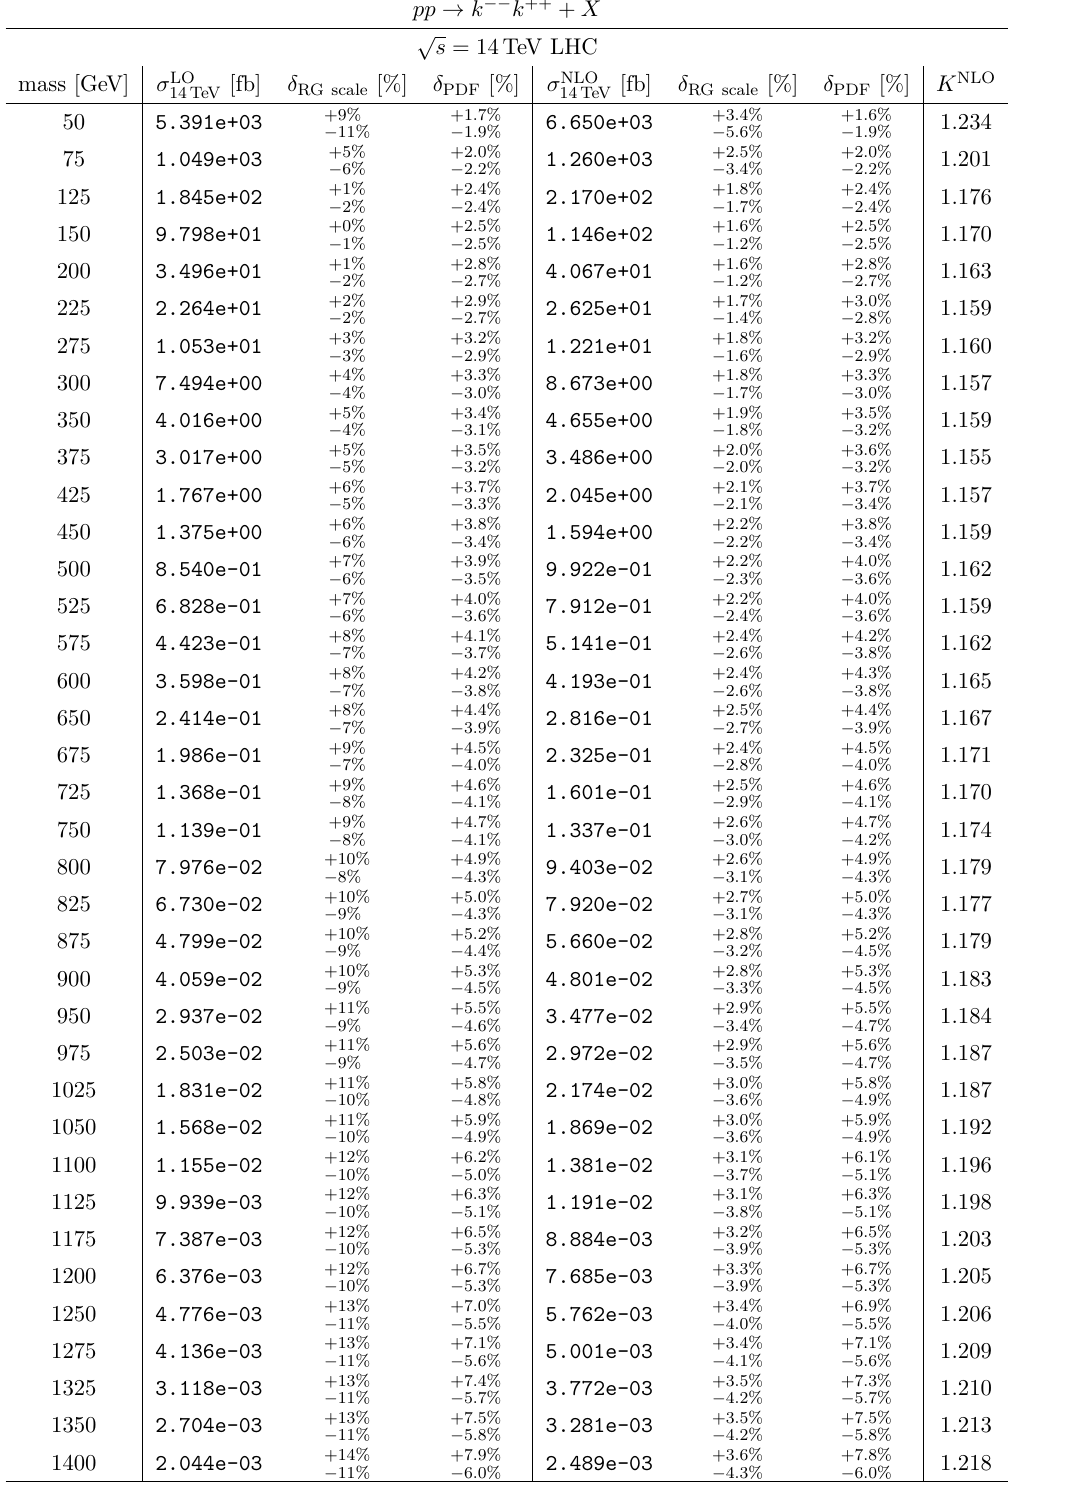
Table 8 . For representative masses m k [GeV] (first column), the predicted cross sections [fb] for √ s = 14 TeV at LO (second column) and NLO (third column) in QCD for inclusive pp → k −− k ++ + X via the Drell-Yan process (DY). Also shown are scale uncertainties [%], PDF uncertainties [%], and the QCD K -factor. See section 3.2 for SM